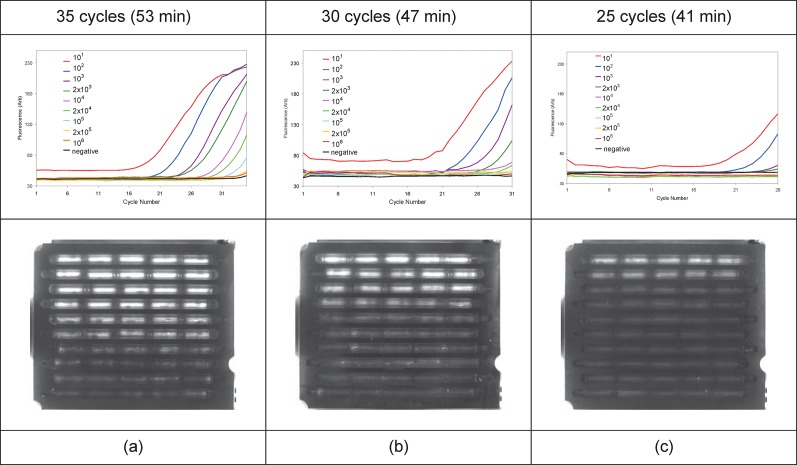
Real-time PCR for the amplification of stx2 gene in diluted overnight culture of E. coli.PCR was performed for (a) 35, (b) 30, and (c) 25 cycles. The curves show fluorescence amplitude versus number of PCR cycles. The second row shows the CCD images at the 35th, 30th, and 25th cycle for each PCR, respectively. Capillaries in trenches 1–8 were hydrated with the diluted culture of E. coli with dilution factors of 101, 102, 103, 2x103, 104, 2x104, 105, 2x105, and 106 respectively. Trench 10 was hydrated with water.